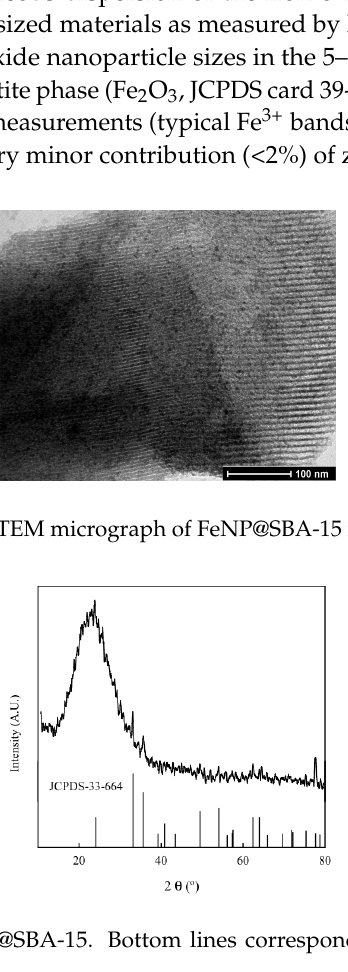
Figure 2. XRD pattern of FeNP@SBA-15. Bottom lines correspond to the JCPDS 39-0664 card of hematite phase Fe 2 O 3 .